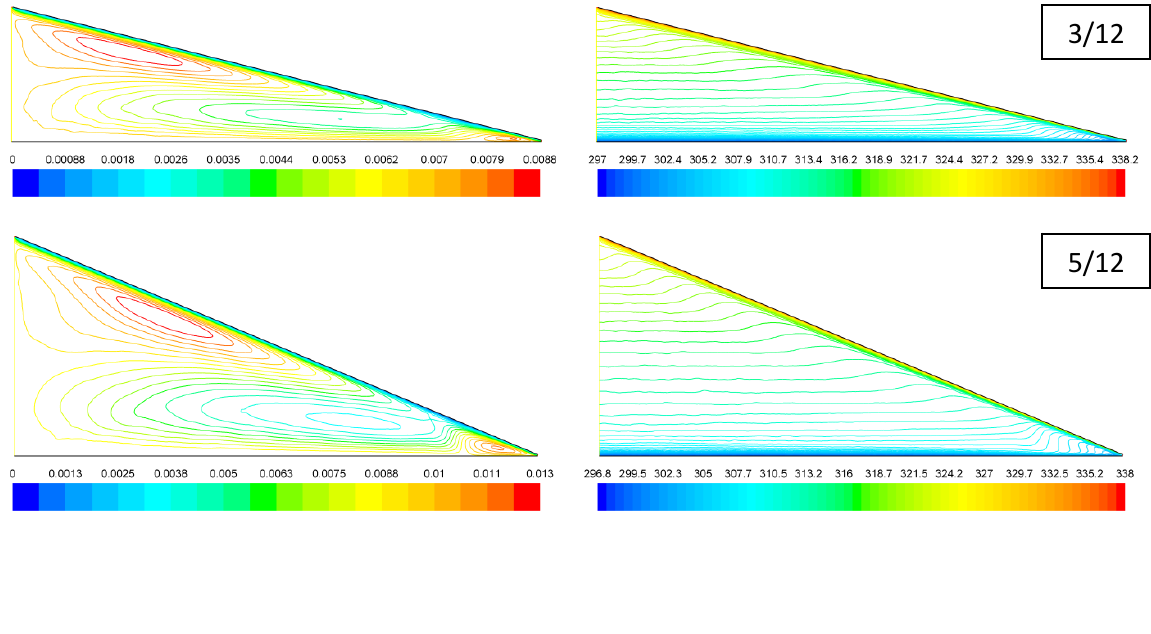
Figure 7. Predicted ( left ) streamlines (in kg/m·s) and ( right ) isotherms (in K) for attics with R-1.2 ceiling